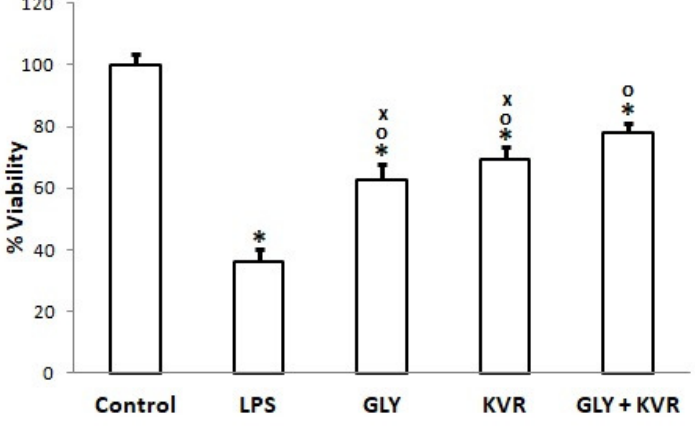
Figure 1. Effect of glycine and kolaviron on lipopolysacharide-induced cell death in U937 cells assessed by MTT assay LPS, cells treated with 1 µg/ml Lipopolysaccaride only; GLY, cells supplemented with Glycine (300 µM) before exposure to Lipopolysaccharide (1 µg/ml); KVR, cells supplemented with Kolaviron (25 µg/ml before exposure to Lpopolysaccharide (1 µg/ml); GLY + KVR, Cells supplemented with both Glycine and Kolaviron (300 µM GLY + 25 µg/ml KVR) before exposure to Lipopolysaccharide. Each bar represents mean ± S.E.M of six replicates expressed as % viability in comparison to control. *Significantly different from control; o Significantly different from LPS and x Significantly different from GLY + KVR. p <